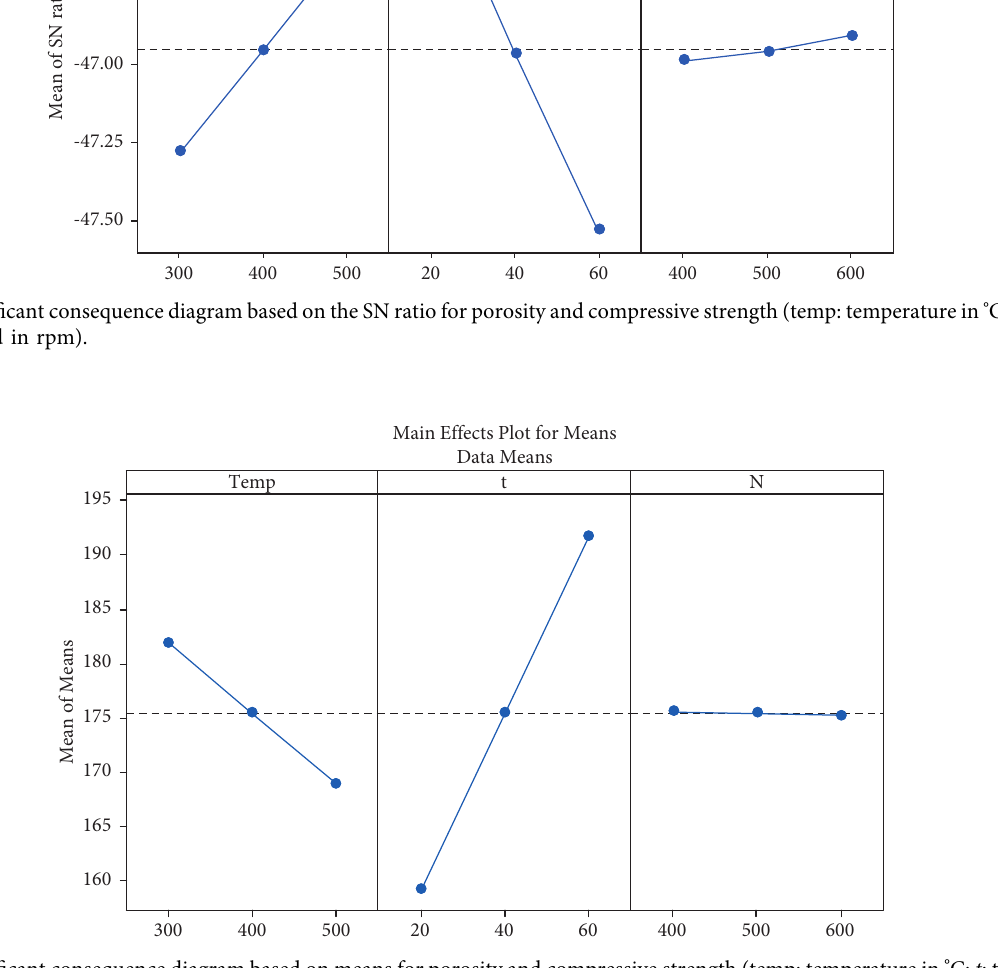
2.3. Porosityand Compressive Strength. After completing the individual optimization based on porosity and compressive strength values, the combination of these two was consid- ered with nominal being the best condition in Table 4.